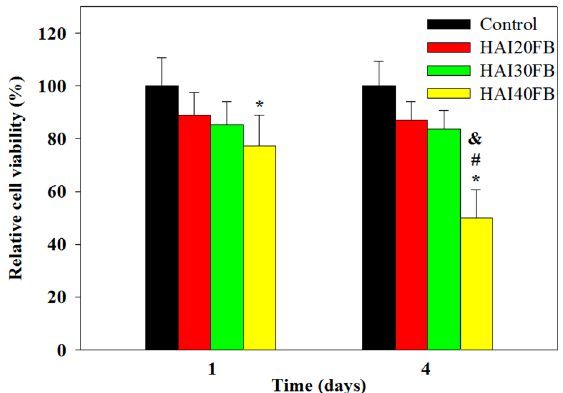
Figure 5. Cytotoxicity of NFMs by culture 3T3 fibroblasts with 24 h extracts (in cell culture medium) of HAI20FB, HAI30FB, and HAI40FB NFMs for 1 and 4 days. The relative cell viability was normalized with cells cultured in fresh cell culture medium (control), which was taken as 100%. * p < 0.05 compared with control; # p < 0.05 compared with HAI20FB; & p < 0.05 compared with HAI30FB.